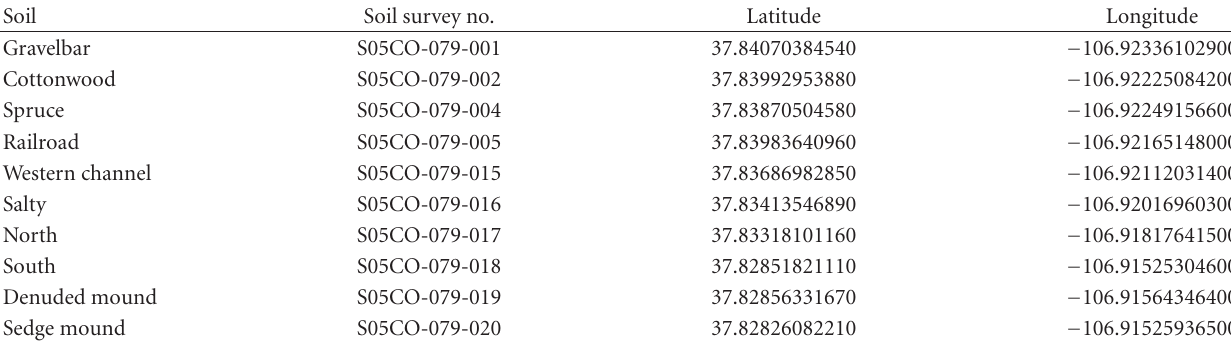
Table 2: Soil names, soil survey numbers, depth, and location (latitude and